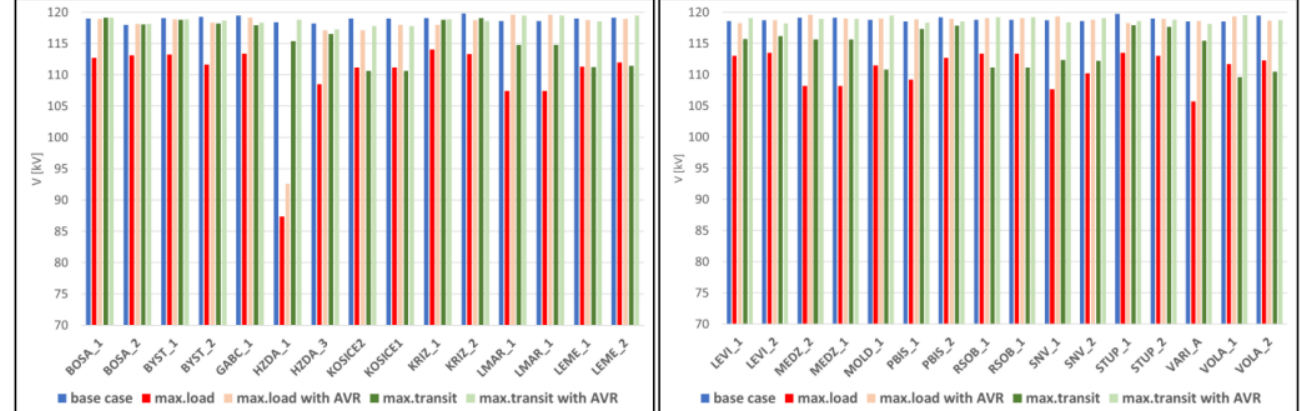
Figure 7. Voltage in 110 kV DS substations: summer.